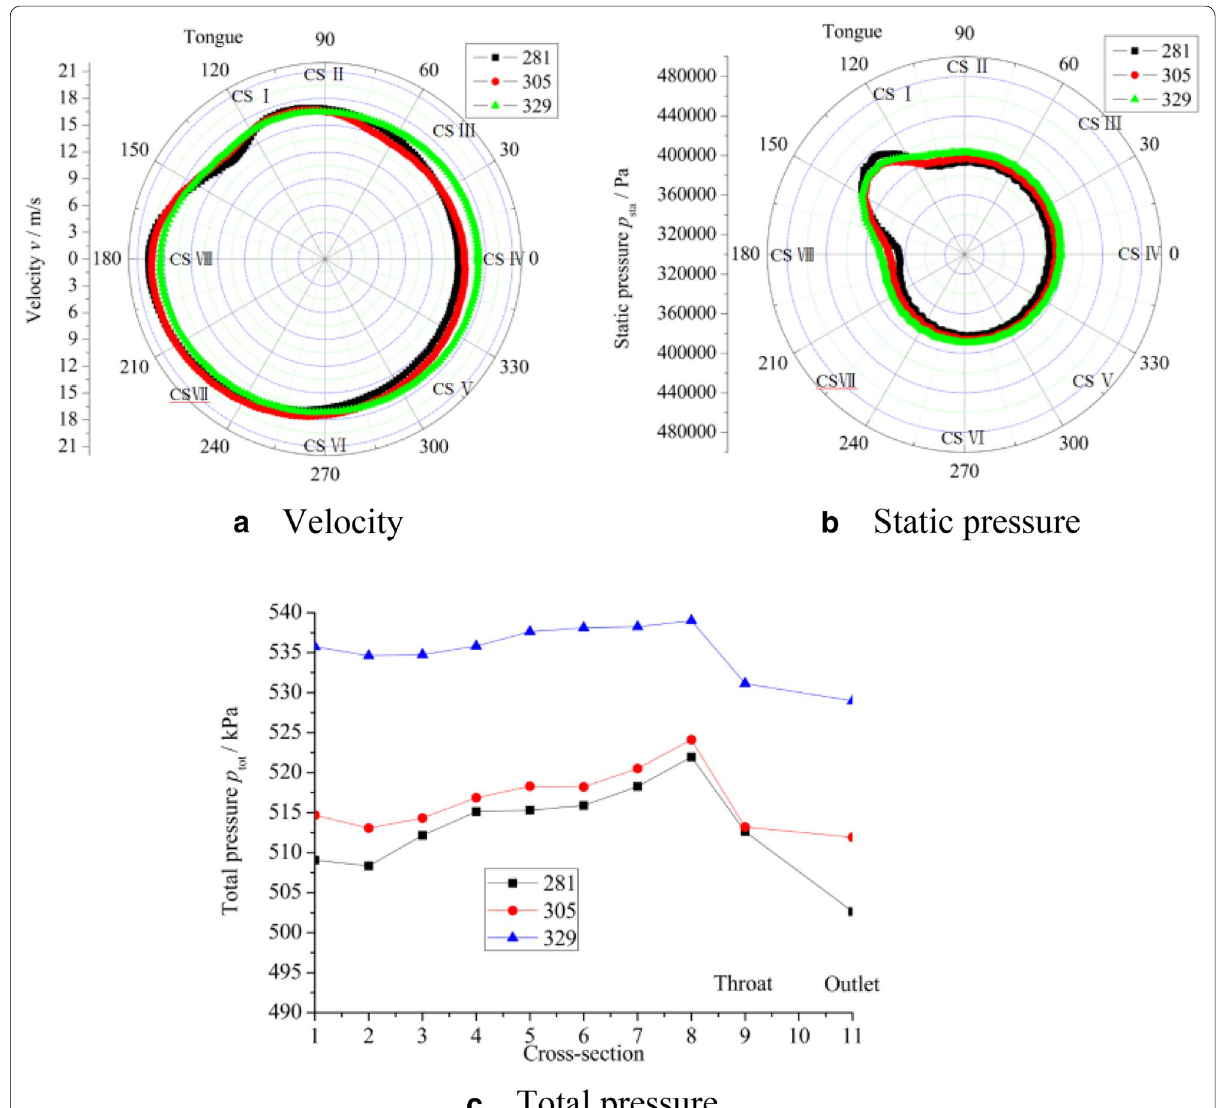
Figure 10 Distribution of pressure and velocity in volute casing at flow rate of 30 m 3